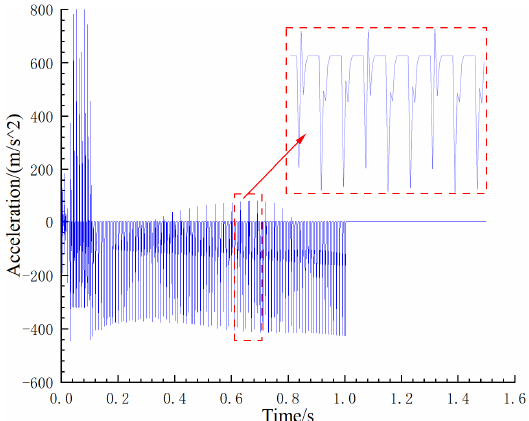
Figure 14. Current curve of No.1 valve.